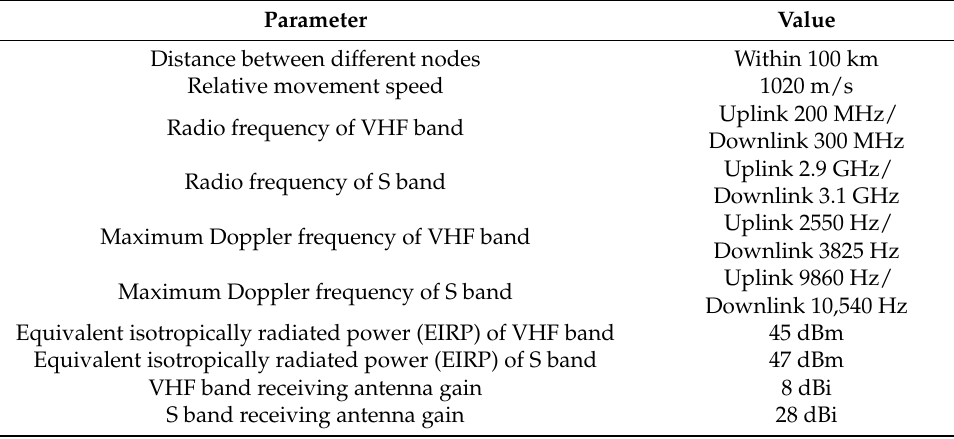
Table 1. The parameter of simulation scenario.